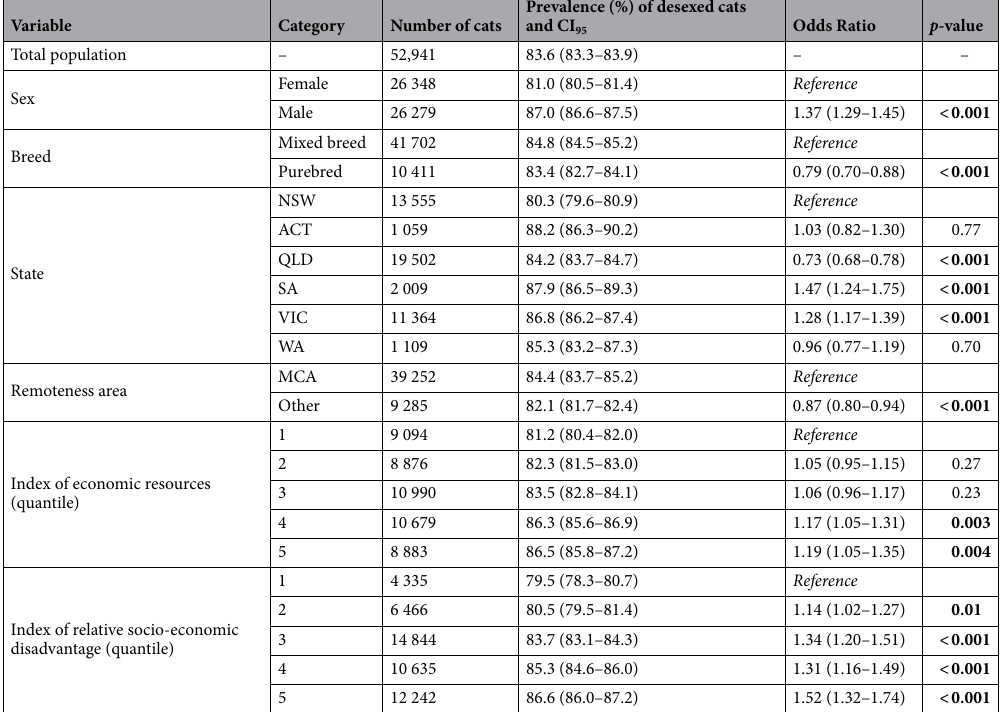
Table 1. Prevalence and predictors of being desexed in an Australian cat cohort born between 2010 to 2017 inclusive. Significant values ( p < 0.05) are indicated in bold. CI confidence interval, MCA major cities of